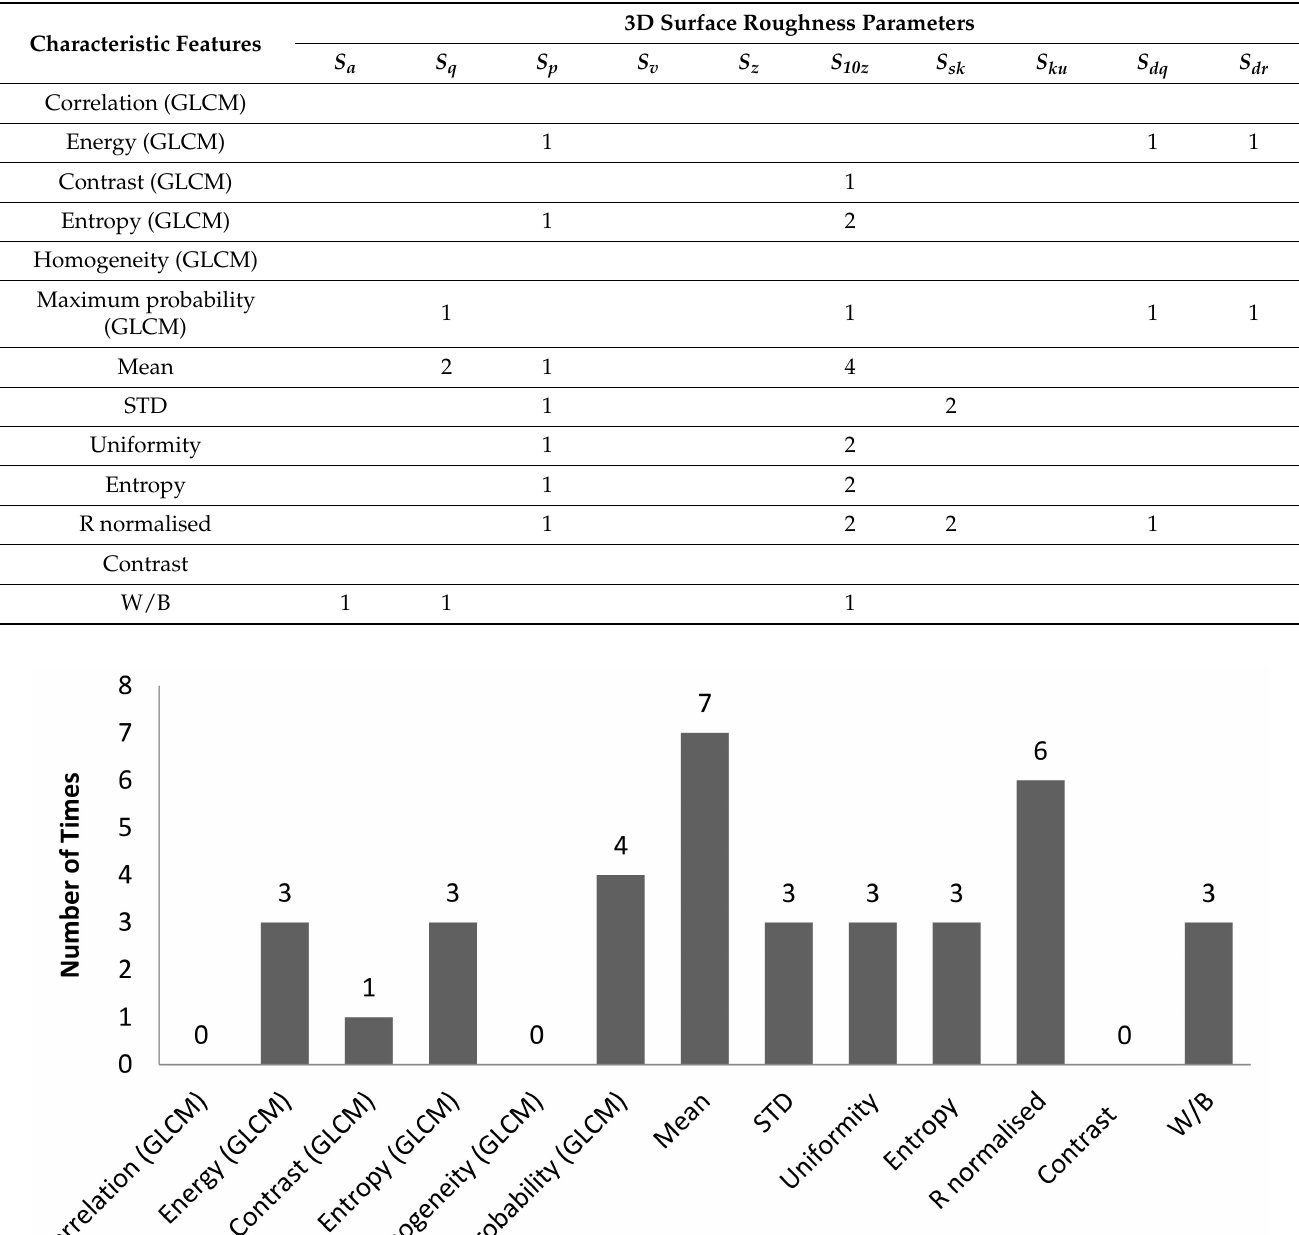
Table 3. Tabulation of the number of times a correlation between characteristic features and 3D